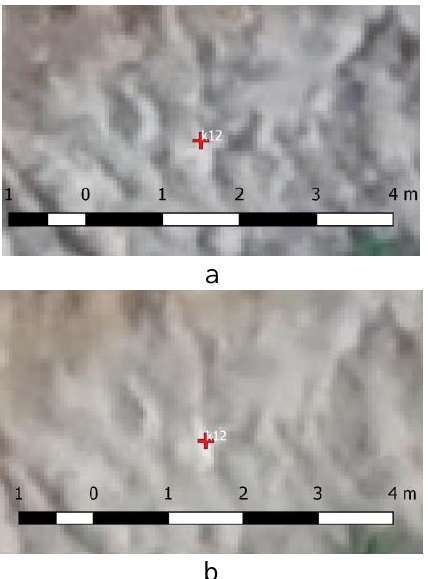
Figure 7. Identification of GCPs (a) fixed-wing, (b)